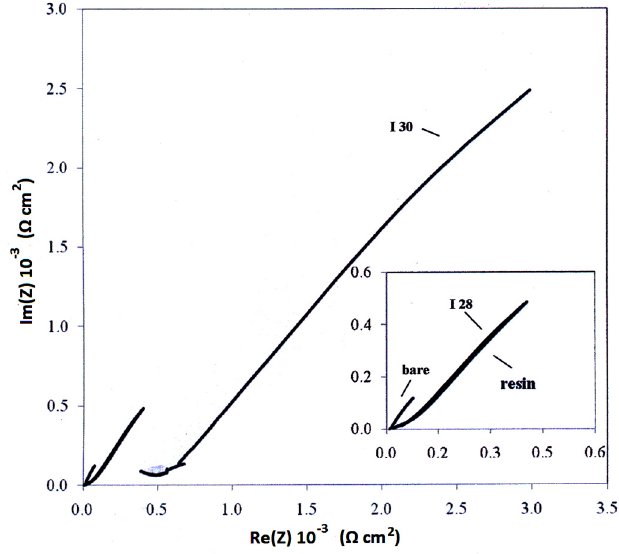
Figure 16. Nyquist plots of impedance spectra, R e (Z), real part of impedance, and I m (Z), imaginary part of impedance, for bare and coated specimens after 4 days of exposure in a corrosive environment of 3.5 wt % NaCl solution. Table 4. Resistance values ( Ω cm 2 ) for bare and coated specimens. Bare— 0 days